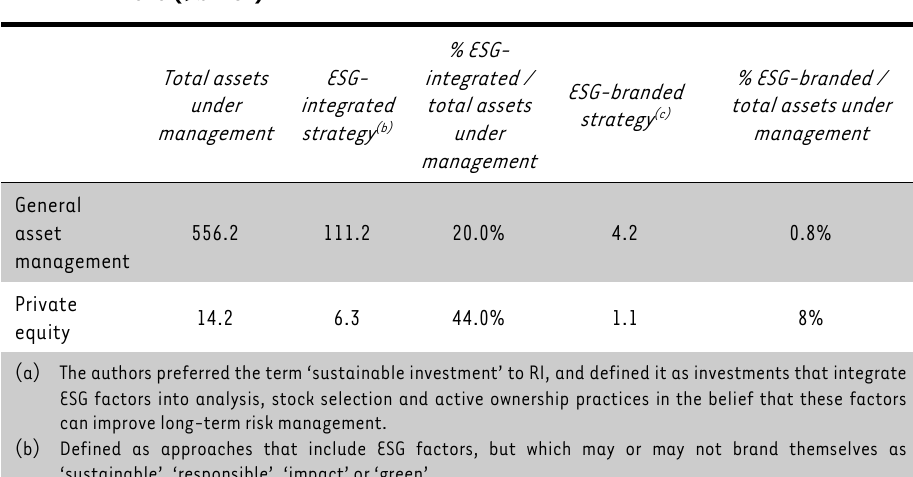
Sustainable investment assets under management in South Africa on 31